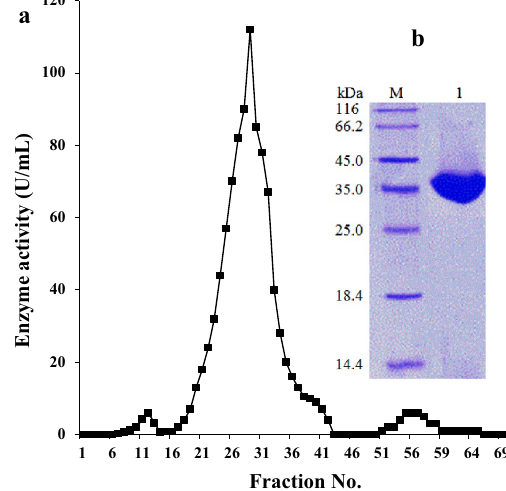
Fraction No. Figure 2. Elution profile of the UcB5 through Sephadex G-75 ( a ) and SDS-PAGE ( b ). Initially, the culture proteins were precipitated with ammonium sulfate at 30–70% concentrations then loaded into a Phenyl Sepharose 6FF column (1.5 × 20 cm 2 ) followed by a DEAE-Sepharose CL-6B column (1.5 × 20 cm 2 ). and a Sephadex G-75 FF column (2.5 × 100 cm 2 ). Finally, SDS-PAGE analysis was done using 5% (w/v) stacking gel and 15% (w/v) separating gel. The gel is cropped with paint software and the previous version of gel is found in the Supplementary information file.